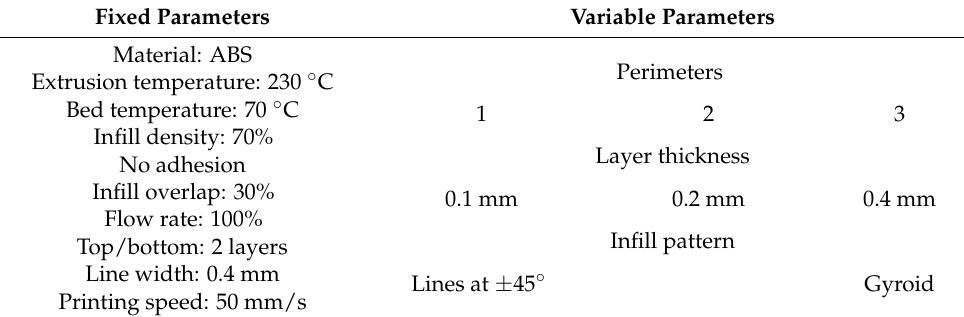
Table 1. Printing parameters and their levels for compression specimens.